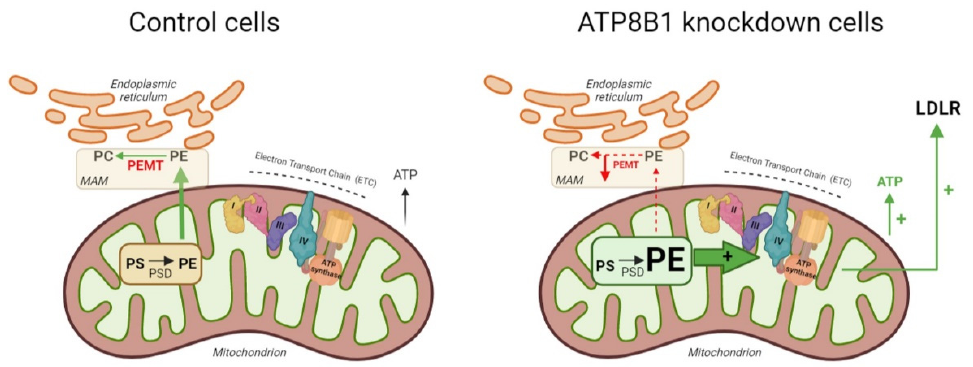
Figure 6. Hypothetical model summarizing the findings described. In mitochondria of control cells (left), phosphatidylserine (PS) is converted to phosphatidylethanolamine (PE) by phosphatidylserine decarboxylase (PSD). PE translocates to the mitochondrial-associated membrane (MAM), where phosphatidylethanolamine methyltransferase (PEMT) catalyzes the conversion of PE to PC. In ATP8B1 knockdown cells (right), PEMT is down-regulated, which leads to elevated mitochondrial PE levels that activate the protein complexes I–IV (IV = ATP synthase) of the electron transport chain (ETC) resulting in elevated OXPHOS and consequent increased ATP production and LDLR expression. Figure was created in BioRender.com.